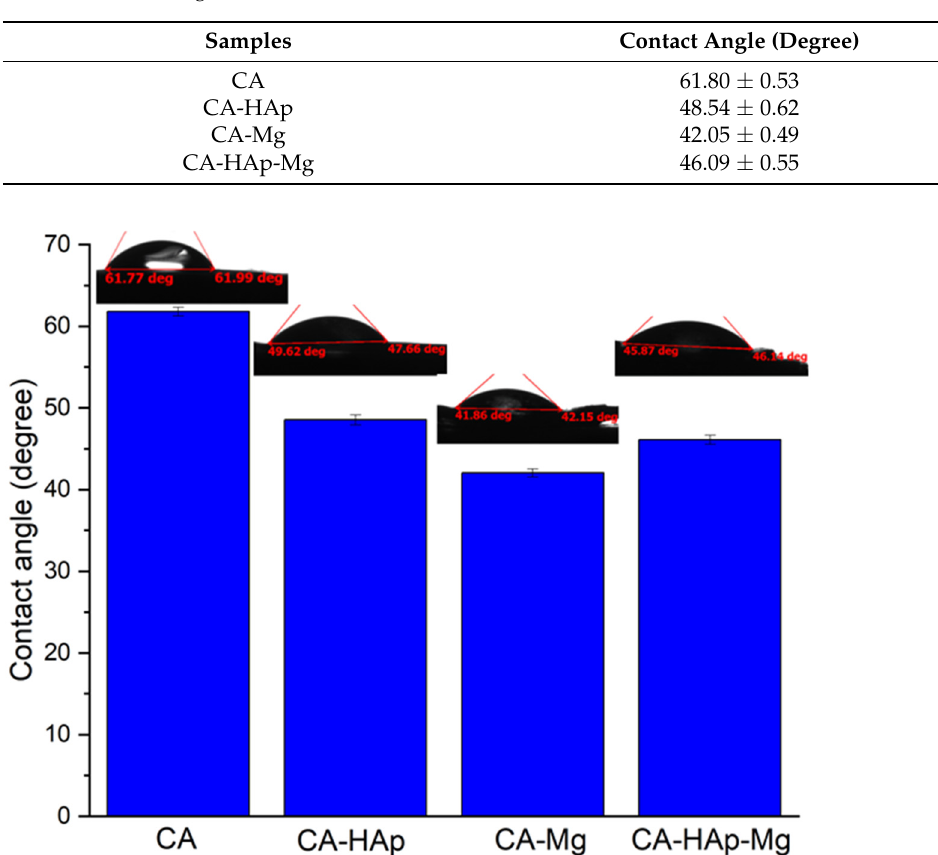
Figure 10. Contact angle values of the experimental samples.